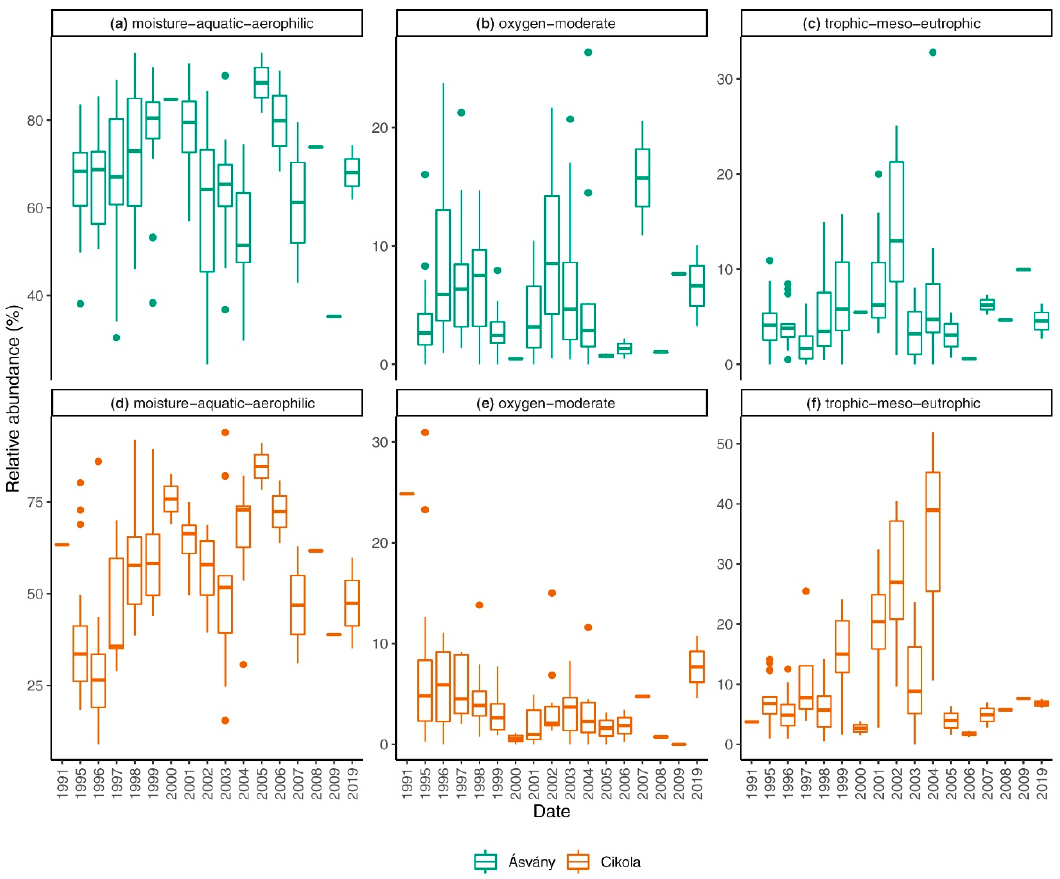
Figure 8. Long-term changes in relative abundance of significant traits of epiphytic diatom assemblages from deployed and natural reeds at a4 and a6 ( a – c ) sites in the Ásvány tributary system (green) and at c5 and c6 sites ( d – f ) in the Cikola tributary system